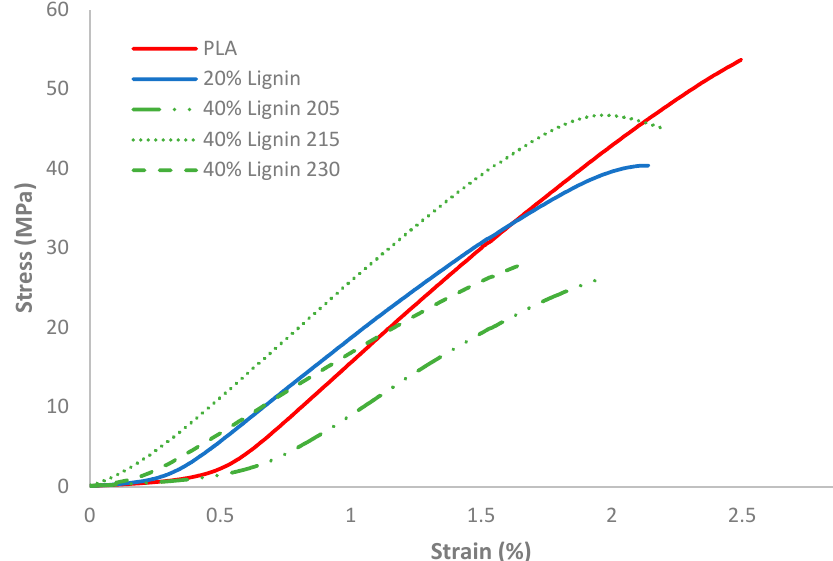
Figure 4. Stress − strain curves for the different biocomposites